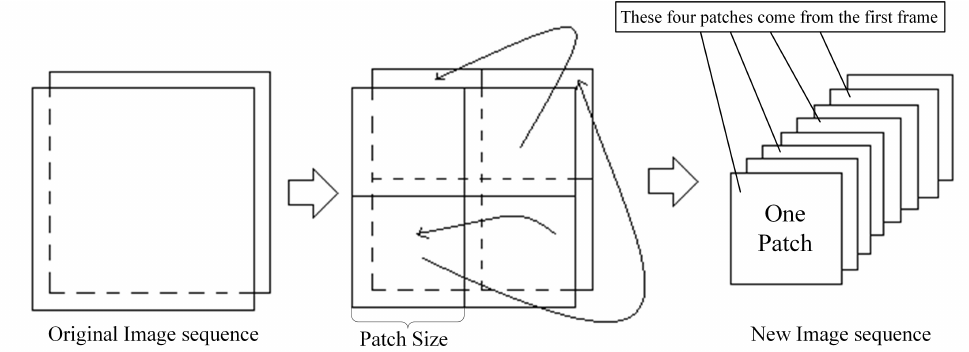
Figure 2. Procedure of obtaining the image patches sequence. The image here is divided into four patches with N frames. These images are concatenated to obtain a new image sequence with T × N